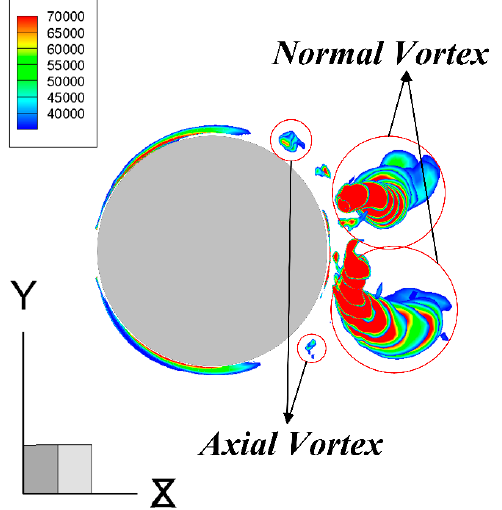
Figure 7. Comparisons of normal and axial vortices.